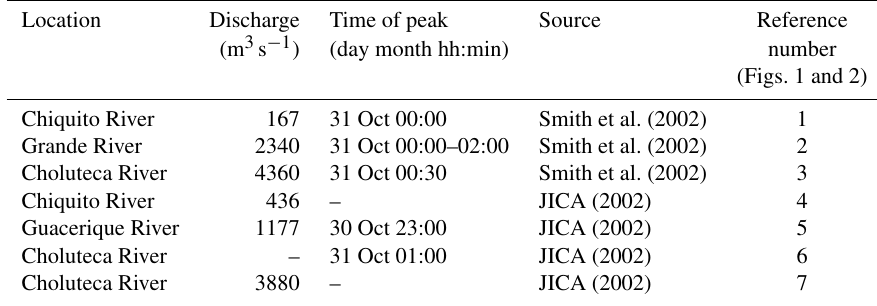
Table 1. Post-event estimated peak discharge and time of peaks. Location